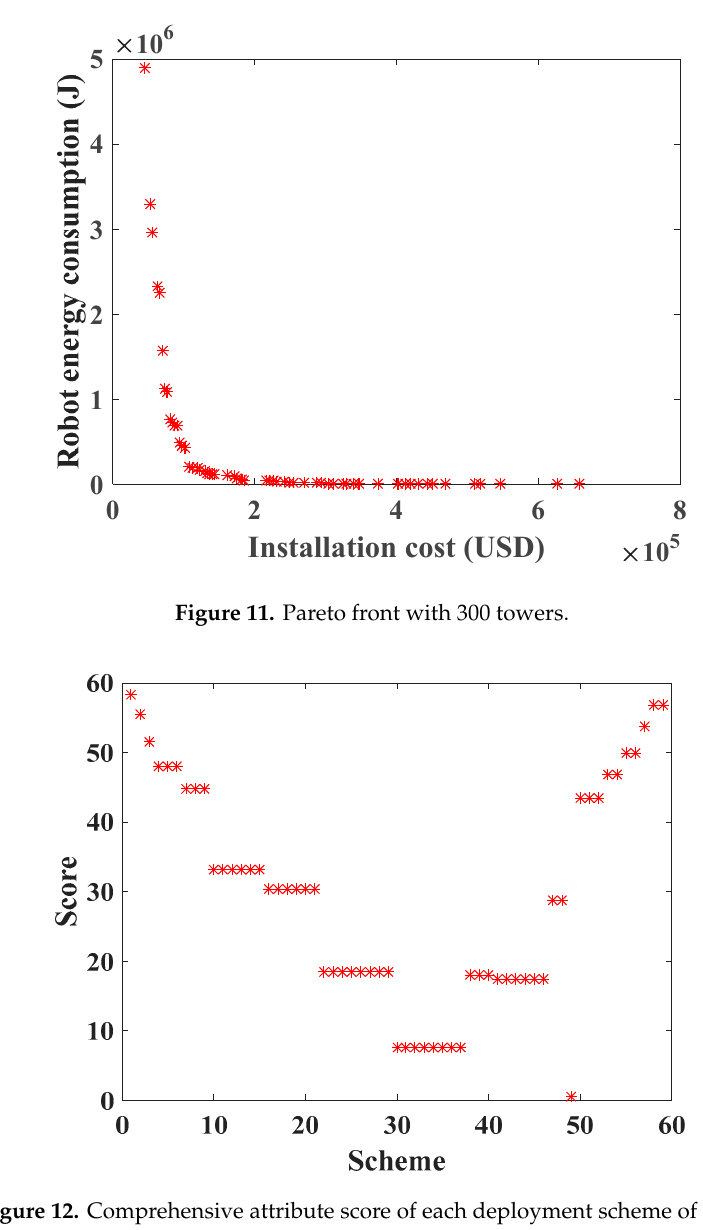
Figure 12. Comprehensive attribute score of each deployment scheme of WRN. Table 6. The specific layout of Scheme 1 and the distance between communication nodes. Tower Number of Installation Communication Node